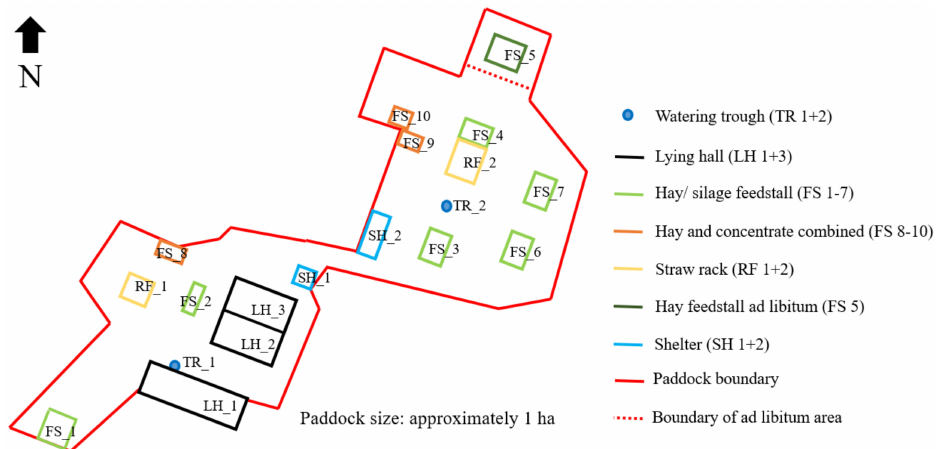
Figure 1. Schematic diagram of paddock area and resources.